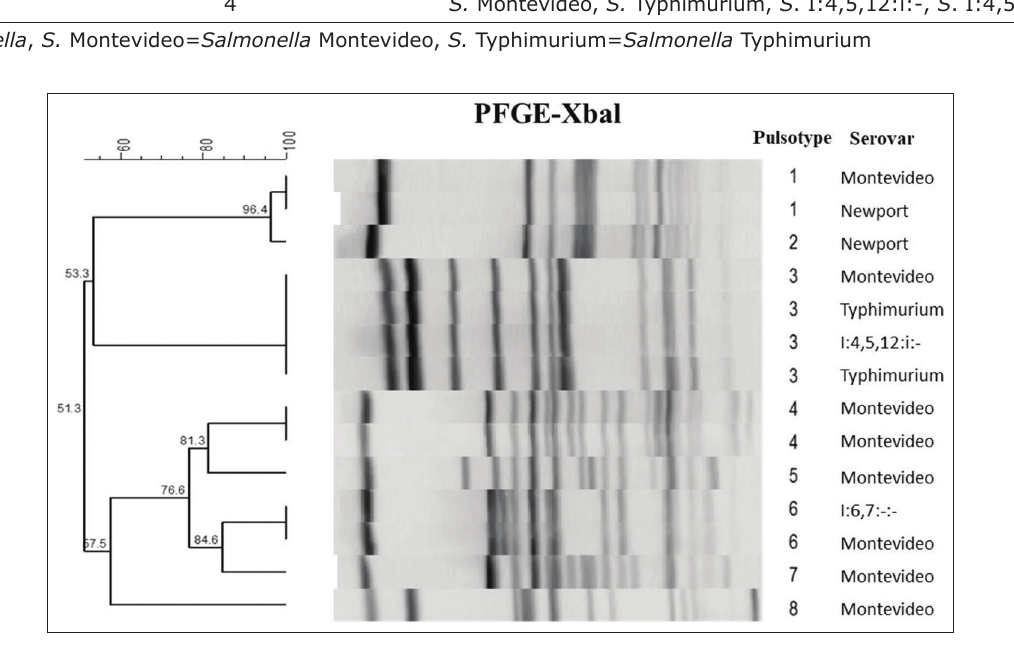
Figure-2: Pulsotype group and associated serotype of 15 randomly selected Salmonella enterica